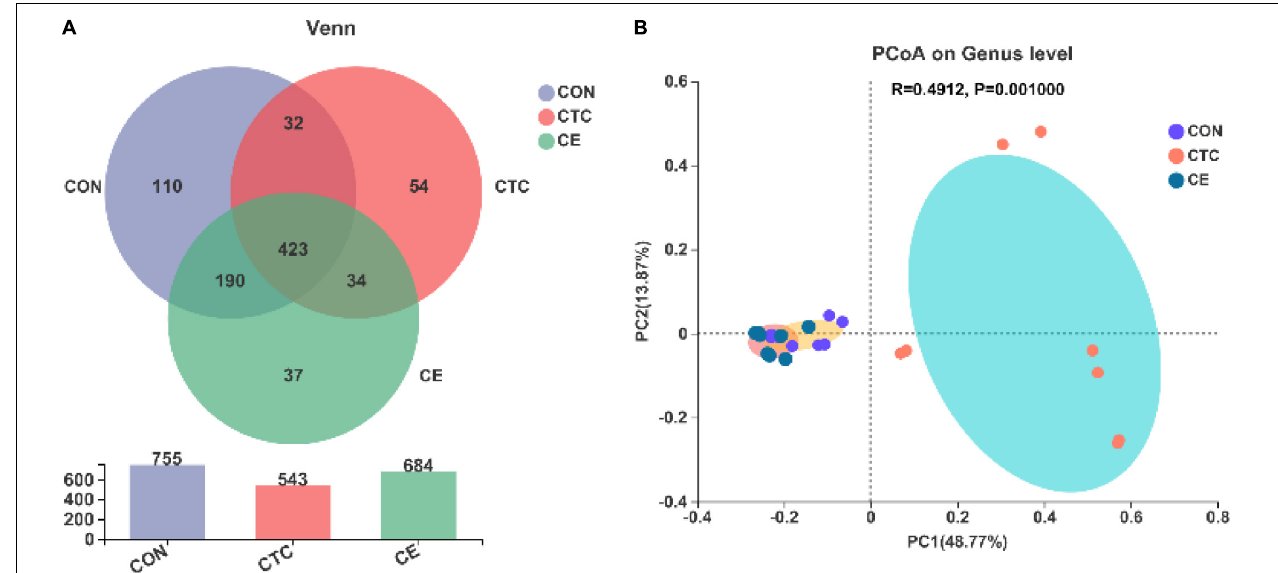
FIGURE 1 | Effect of compund enzymes on cecal OTU of pigs (A) . β -diversity of cecal microbes in piglets (B) . The individual minipig was regarded as the experimental unit, n = 8 for CE, n = 8 for CON, and n = 8 for CTC. CE, compund enzyme group; CON, basal diet group; CTC, chlortetracycline